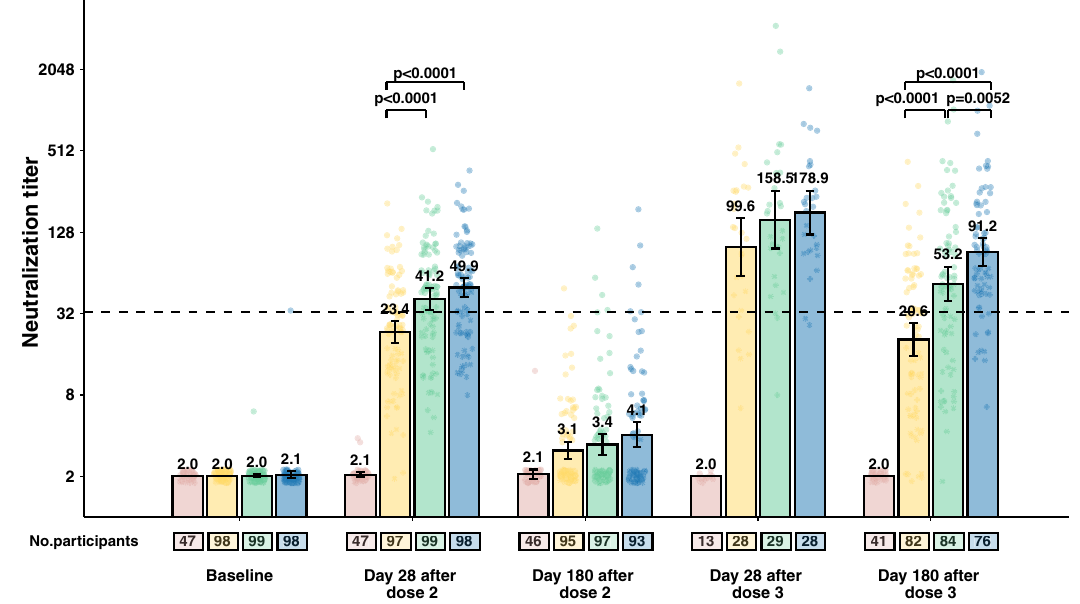
Fig. 2 Neutralising antibody levels to ancestral SARS-CoV-2 in cohort 3-28d-8m (adults aged 60 years and older). The number of participants for each group (placebo group, pink; 1.5 μ g group, yellow; 3 μ g group, green; 6 μ g group, blue) at each visit included in the analysis is provided below the bars. Dots are reciprocal neutralising antibody titres for individuals in the per-protocol population. Numbers above the bars are geometric mean titres (GMTs), and error bars indicate 95% CIs. GMTs and corresponding 95% CIs were calculated on the basis of standard normal distributions of log-transformed antibody titres. Numbers above the short horizontal lines are p values for comparisons between the 1.5 μ g group, the 3 μ g group and the 6 μ g group using ANOVA models with log-transformation. Bonferroni correction done as a post hoc test if the variance was signi fi cant. Only P values indicating signi fi cant differences are marked. Titres lower than the limit of detection (1:4) are presented as half the limit of detection. The dotted horizontal line represents the protective threshold